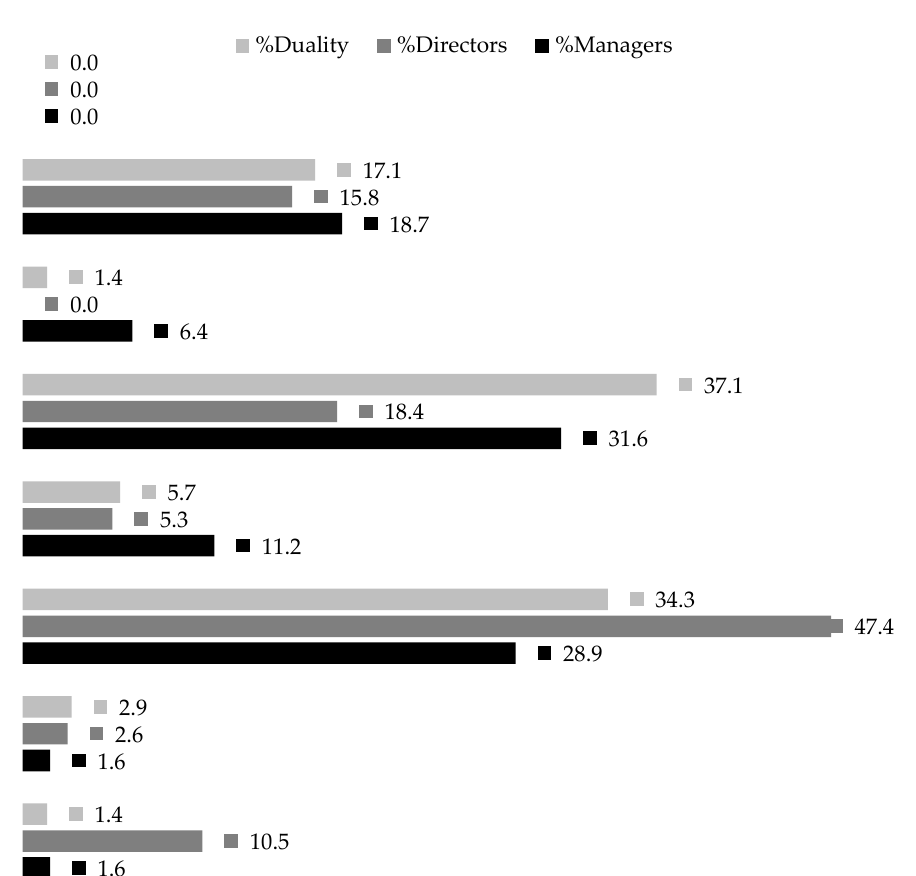
Figure 2. Distribution of Management Teams in the IBEX 35 companies by age group, position, and gender. Source: SABI database. IBEX companies’ annual reports.